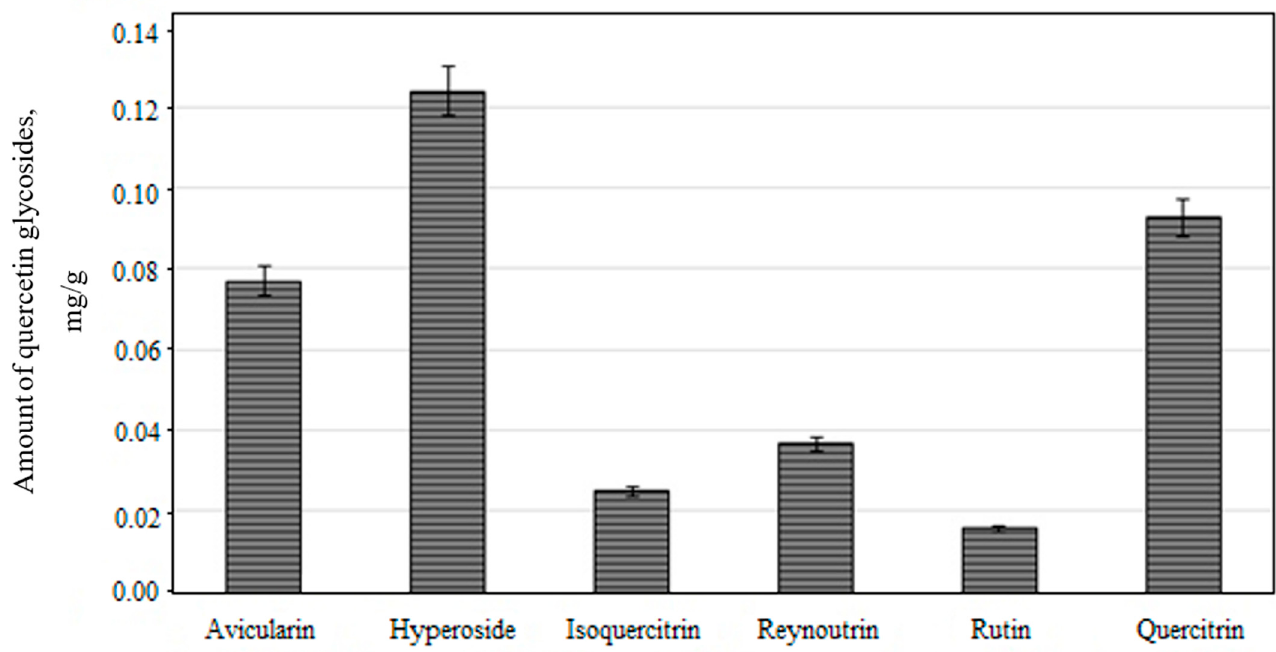
Figure 3. Concentration of individual quercetin glycosides in ethanol extracts obtained from the fruit of the “Ligol” apple cultivar grown in Lithuania.